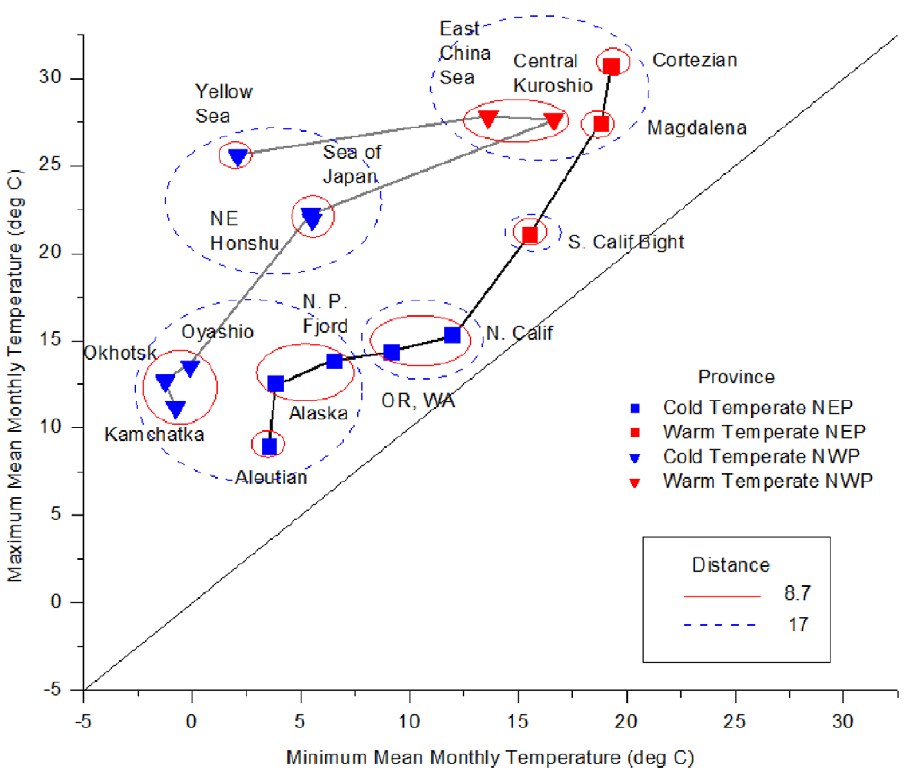
Figure 6. Ecoregions plotted by maximum monthly versus minimum monthly-mean SST over the 29-year record. The y=x line indicates where minimum and maximum temperatures within an ecoregion are identical. Hence, proximity to the line indicates minimal variability in seasonal monthly SST. The Euclidean distances of 8.7 and 17 were obtained through clustering analysis. Solid lines connect ecoregions in order of latitude along the NEP and